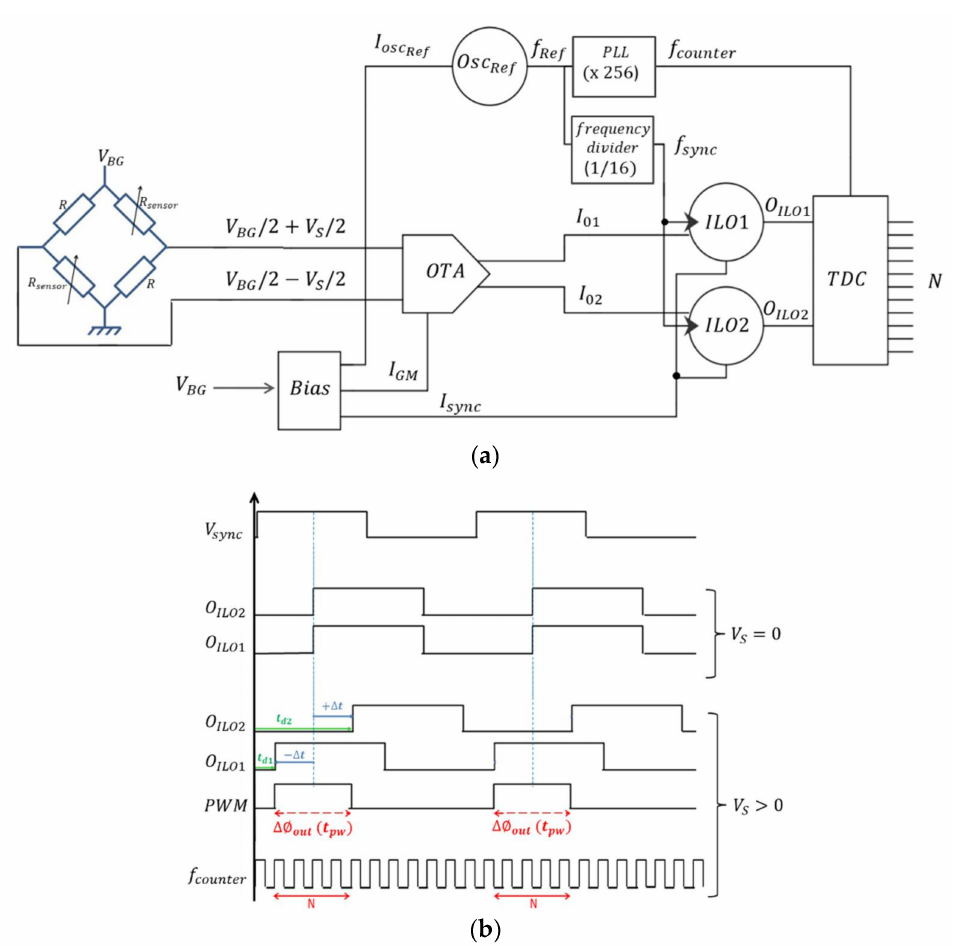
Figure 7. The sensor interface: ( a ) Architecture of the sensor interface; ( b ) Timing diagram (Case of V S >